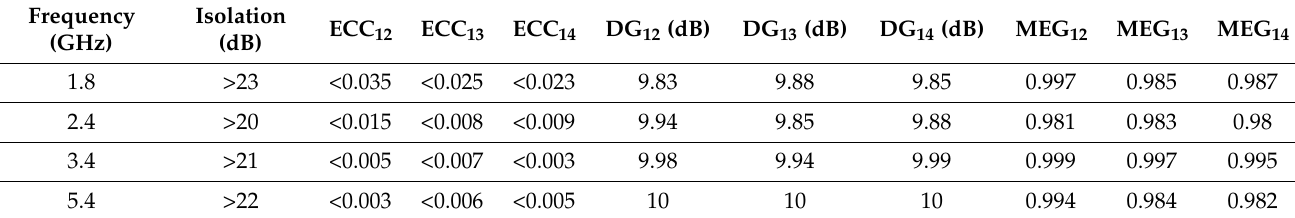
Table 2. Diversity performance of the proposed DS MIMO